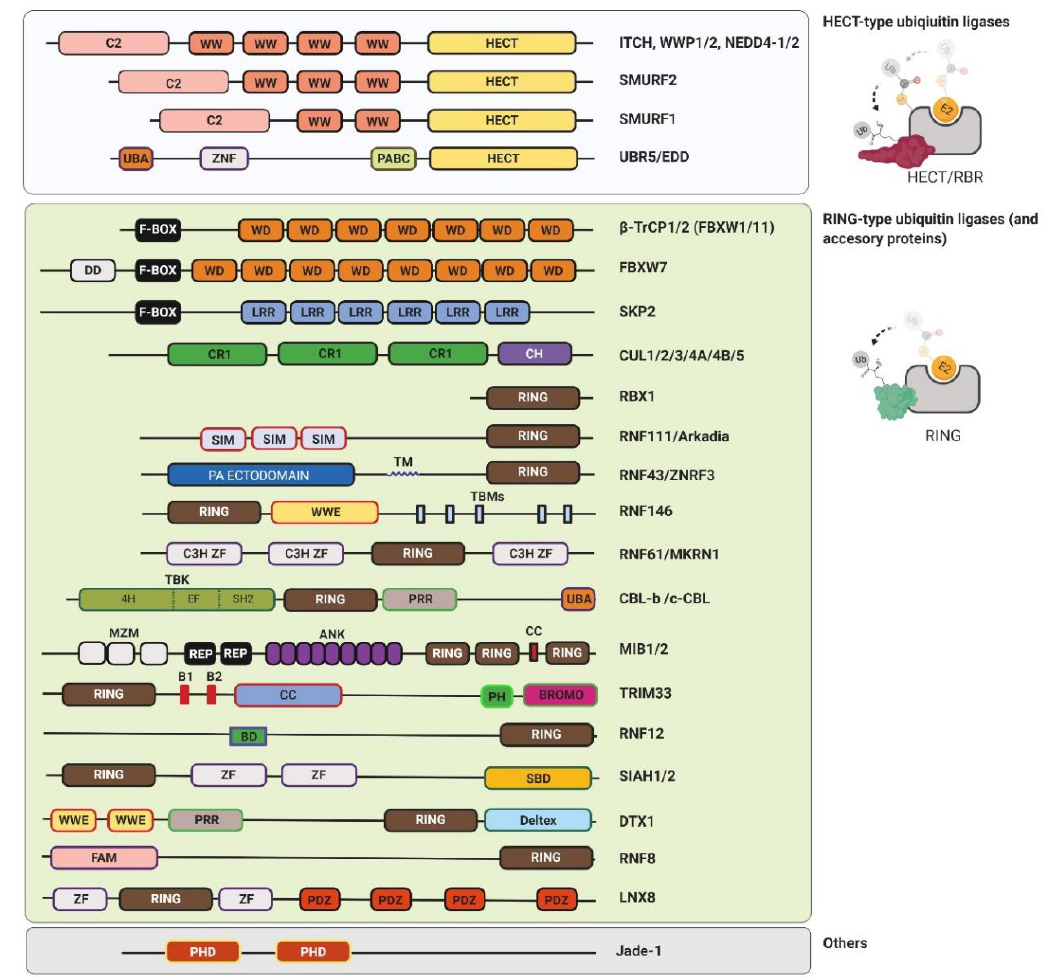
Figure 2. The modular structure of ubiquitin ligases involved in the Wnt, TGF- β , and Notch